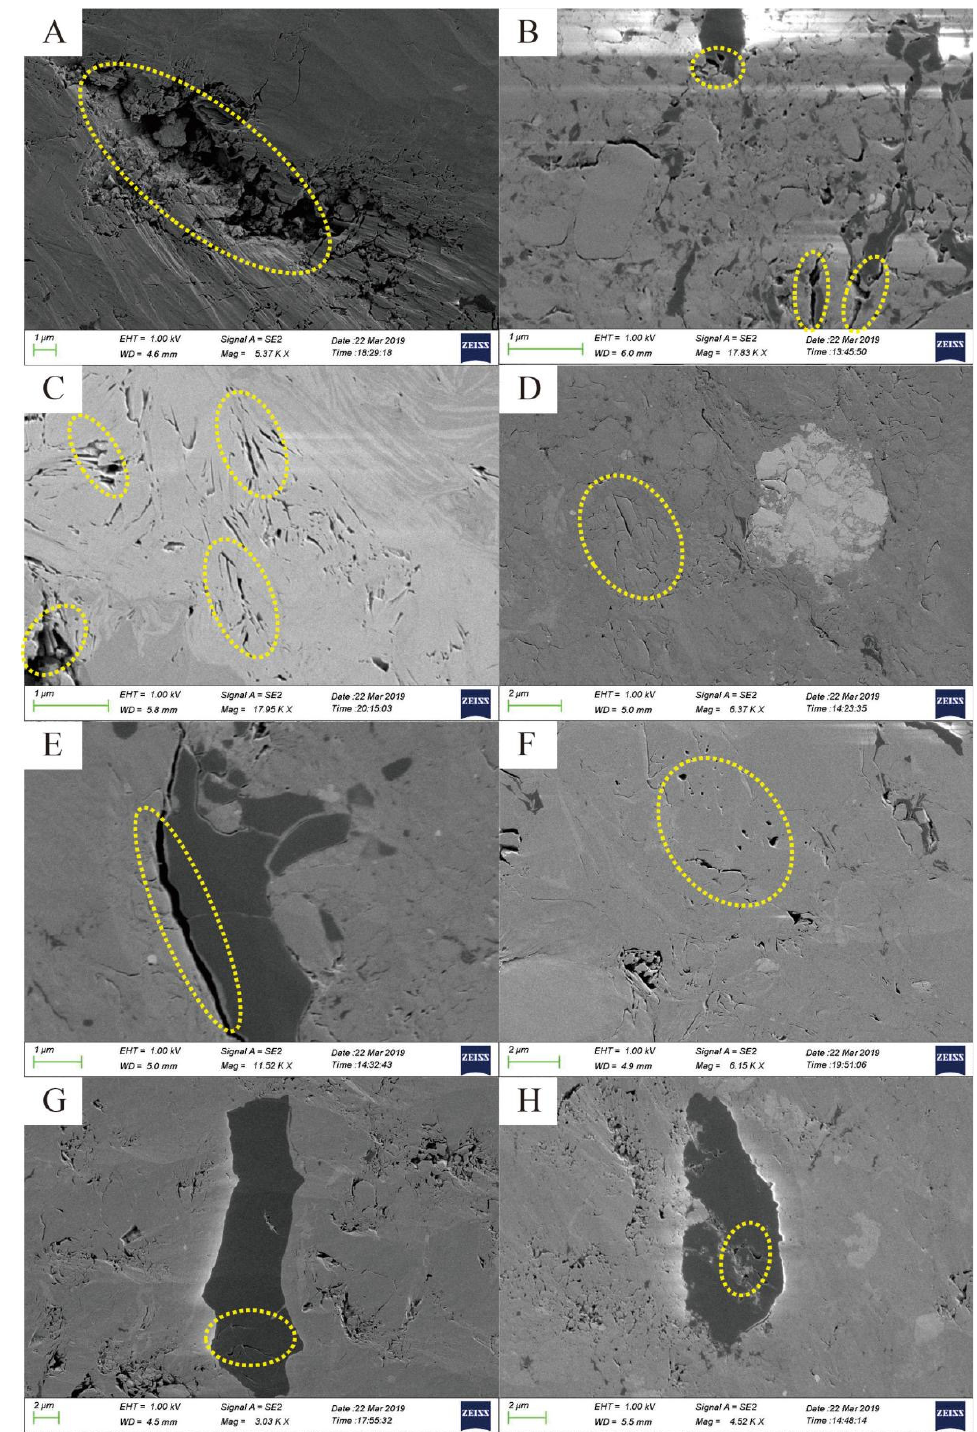
Figure 2. Selected FE-SEM micrographs for sample HS1-1, which were collected from the second member of the Shahezi Formation (K 1 sh 2 ) in borehole HS1 at a depth of 2551.53 m: ( A ) dissolution pores between the margins of quartz and feldspar; ( B ) dissolution pores at the edges of mineral matrix and OM; ( C ) inter-layer pores related to clay minerals; ( D ) micro-fractures developed between skeleton mineral particles; ( E ) micro-fractures presented along the edges of OM and skeleton minerals; ( F ) intra-granular pores within mineral particles; ( G ) slit-shaped organic pores; ( H ) sphere-shaped organic pores.